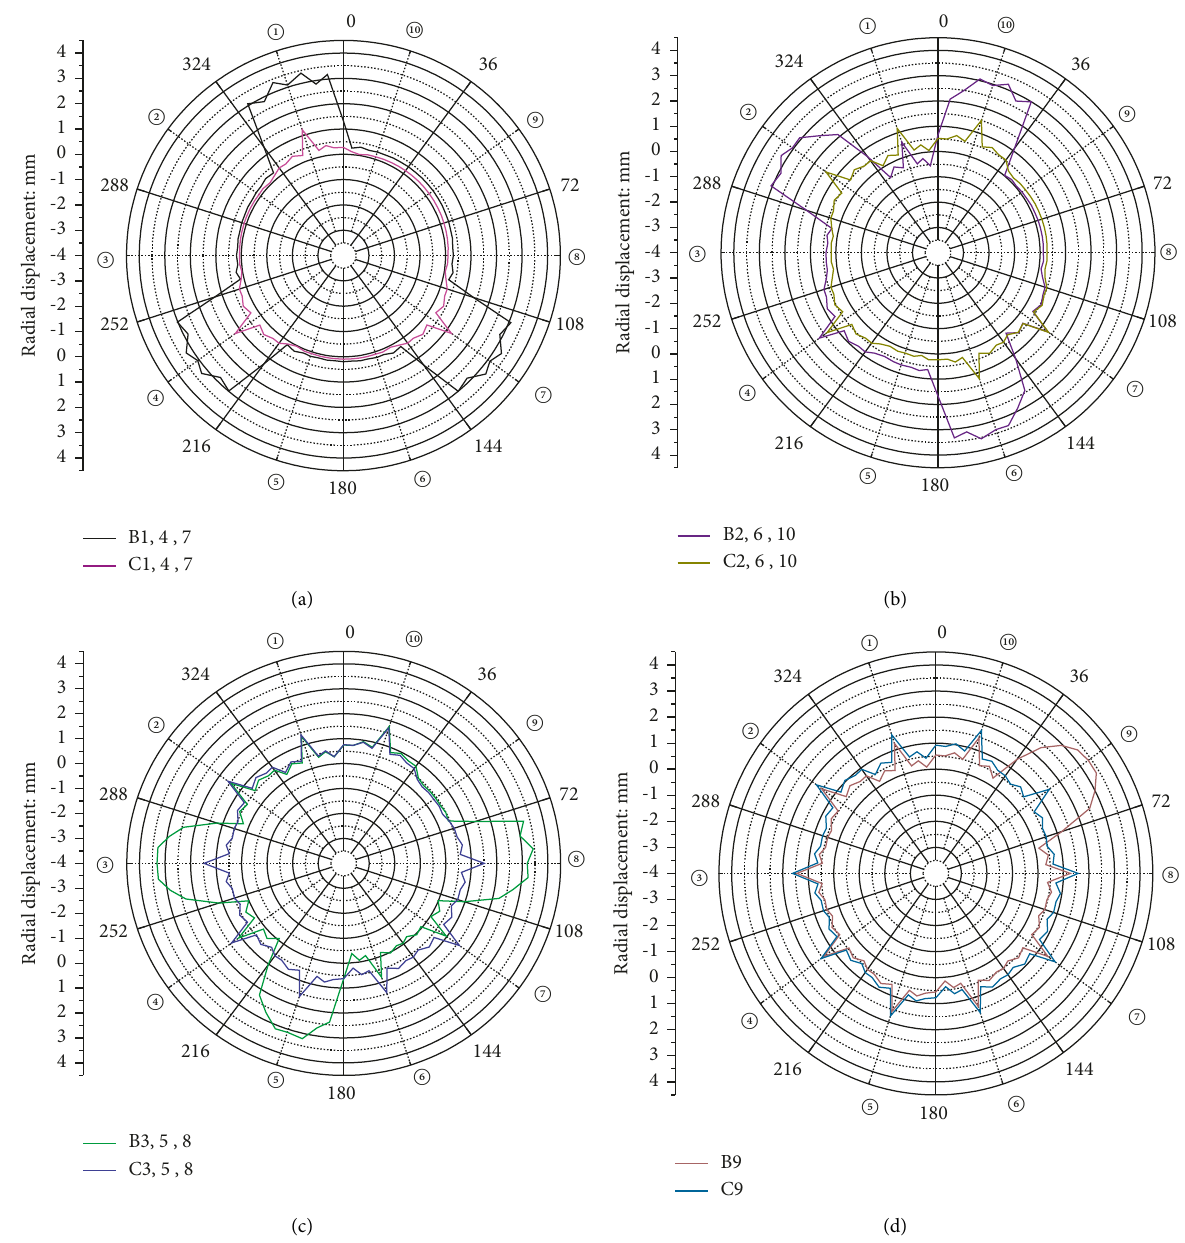
Figure 16: Distribution of radial displacement behind all walls in the soil at a depth of 20.48m for various steps of